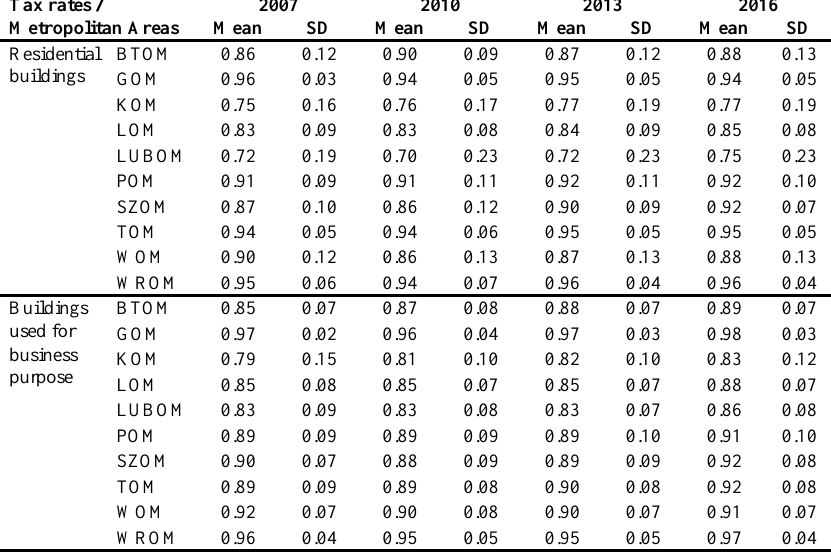
Table 2. Relative major tax rates on land and buildings in selected metropolitan areas in Poland from 2007 to